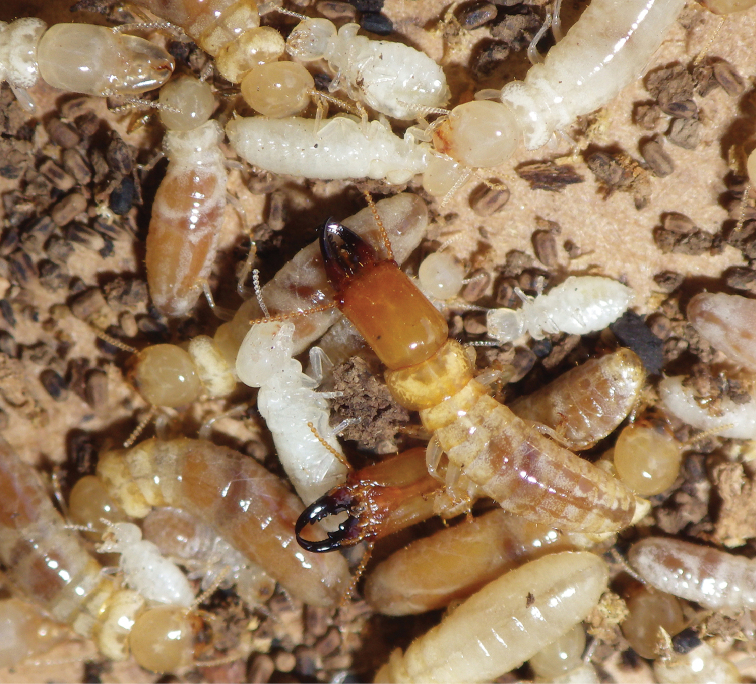
Field habitus of a soldier and pseudergates of Rugitermes
rufus.